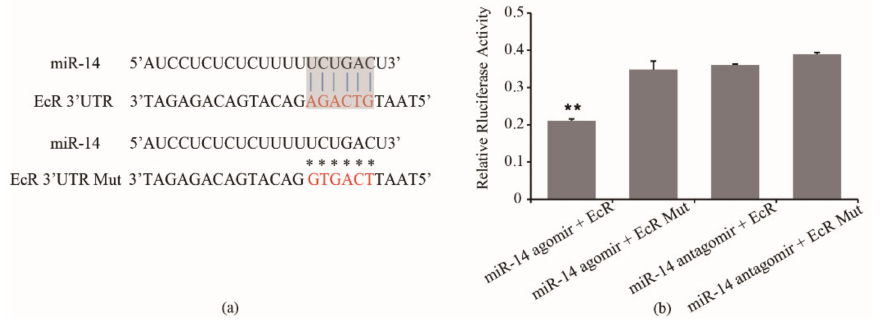
Figure 4. ( a ) Sequences of the interaction sites between miR-14 and EcR 3 (cid:48) UTR and ( b ) co-transfection of psiCHECK2- EcR 3 (cid:48) UTR resulted in dramatic suppression of the luciferase activity. a. Blue line indicates interaction sites, and asterisks indicate mutated site. Nucleotides of interaction sites and mutated sites are shown in red. Grey shaded areas indicate canonical 7mer “seed” region that aligns with the target site, the vertical lines indicate contiguous Watson–Crick pairing. b. A normalized firefly/renilla luciferase value was plotted with ± SD. ** means p <